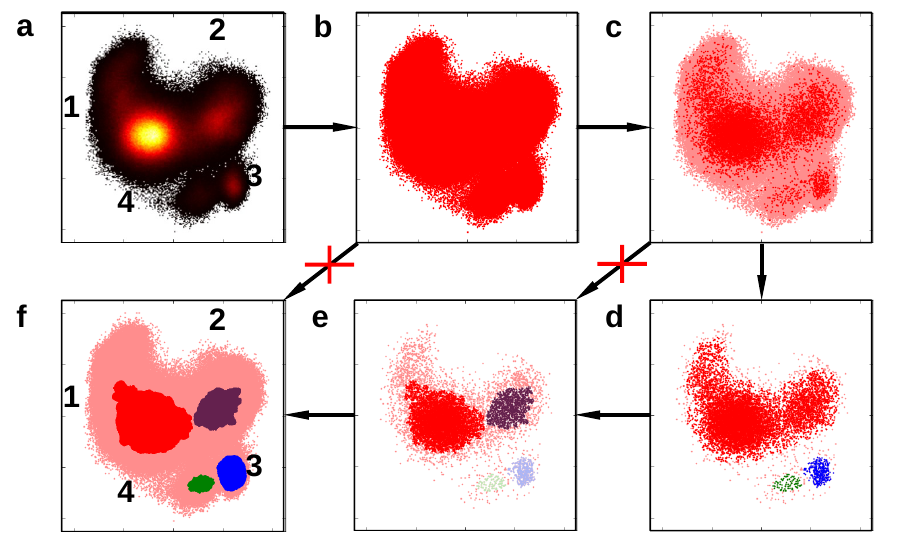
Figure 6. Hierarchical clustering: ( a ) the density of a molecular dynamics simulation trajectory projected onto two meaningful coordinates; ( b ) the dataset of the trajectory; ( c ) a reduced dataset ( red ) for the clustering; ( d ) outcome of the first clustering step; ( e ) outcome of the second clustering step; ( f ) final core sets. A direct step from ( b – f ) is not possible because of the dataset size. A direct step from ( c – e ) is not possible because of the high difference in the cluster